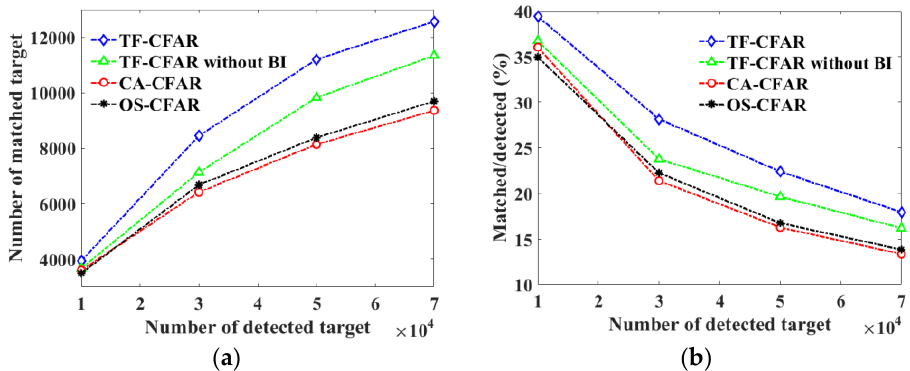
Figure 13. Comparison of the numbers of detected and matched targets on 25 September 2015. ( a ) The number of matched targets and ( b ) the percentage of the matched targets out of the detected targets versus the number of detected targets.